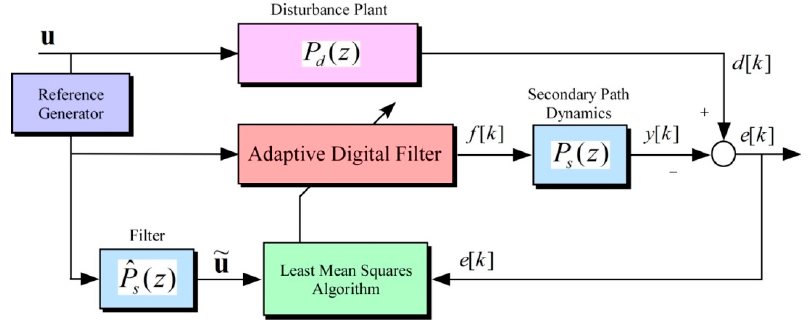
Figure 2. Filtered-X least mean square algorithm.